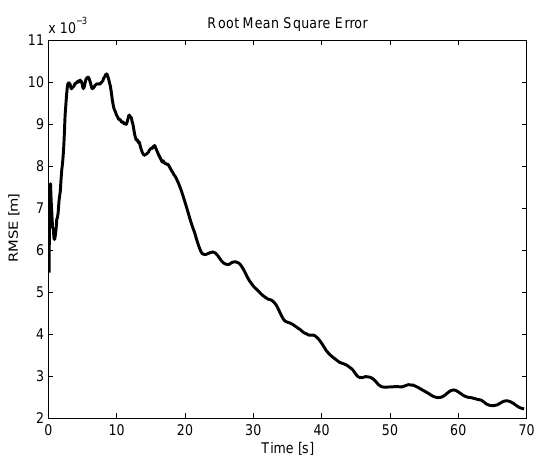
Fig. 7. The RMSE plot for the entire time of assimilation. Fig. 8. The forecast skill plot for about 4s period of forecast